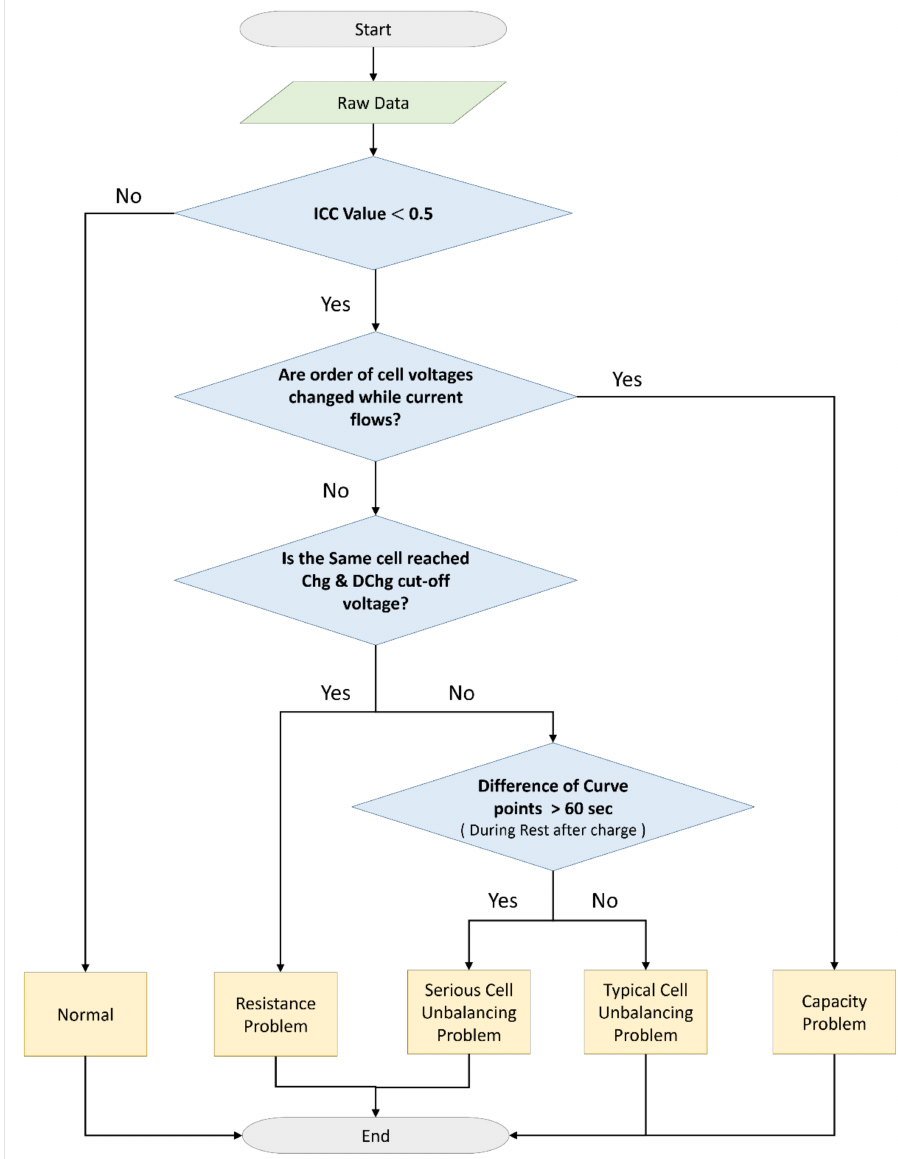
Figure 2. Proposed flowchart for abnormality